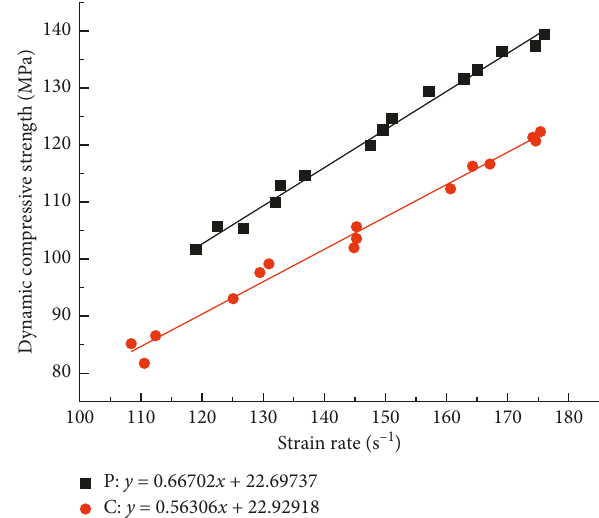
Figure 5: Dynamic compressive strength as a function of strain rate for parallel- (P-) bedding and vertical- (C-) bedding samples.